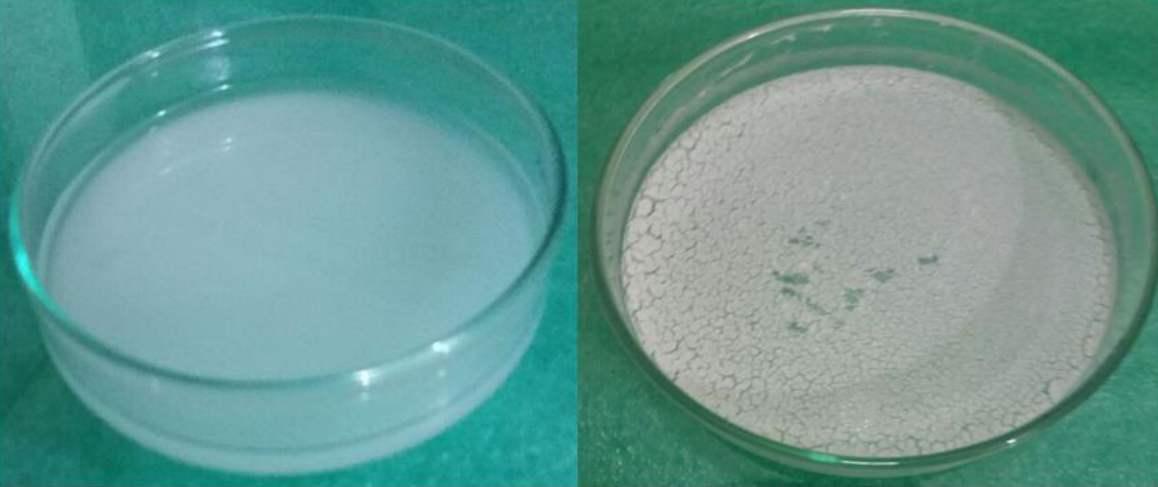
Figure 11. Drug loading of synthesized nanosponges before and after lyophilization.